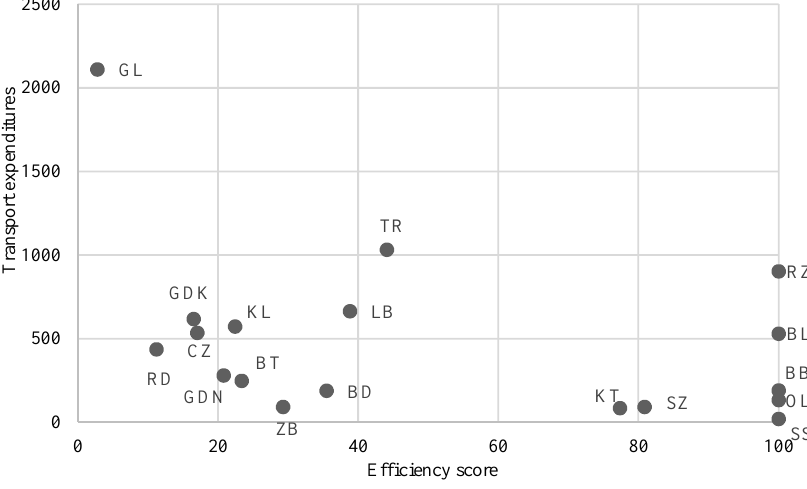
Figure 4. The efficiency score and transport expenditures in